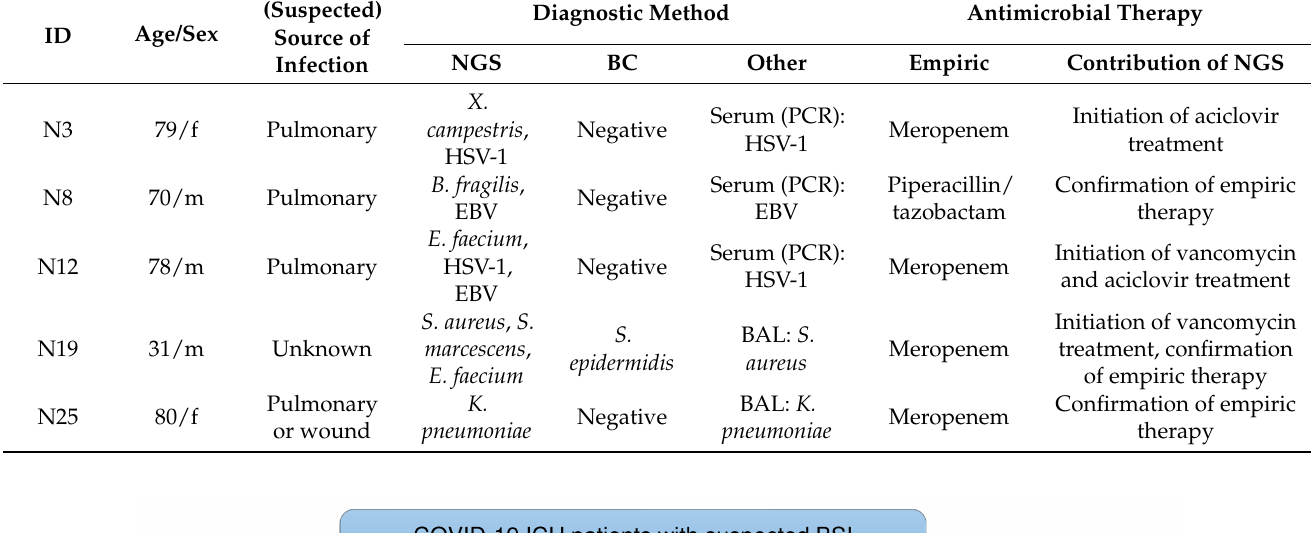
Table 3. Contribution of NGS to the optimization of antimicrobial therapy. NGS results led to the initiation of four targeted therapies in three cases. Aciclovir was administered in two cases after HSV-1 was detected by NGS and confirmed by PCR. Vancomycin was started in two cases following the detection of E. faecium by NGS. In three cases, following pathogen detection by NGS, ongoing empiric therapy was considered appropriate and was continued accordingly. BAL: bronchoalveolar lavage; BC: blood culture; EBV: Epstein–Barr virus; HSV-1: herpes simplex virus type 1; NGS: next-generation sequencing; PCR: polymerase chain reaction.